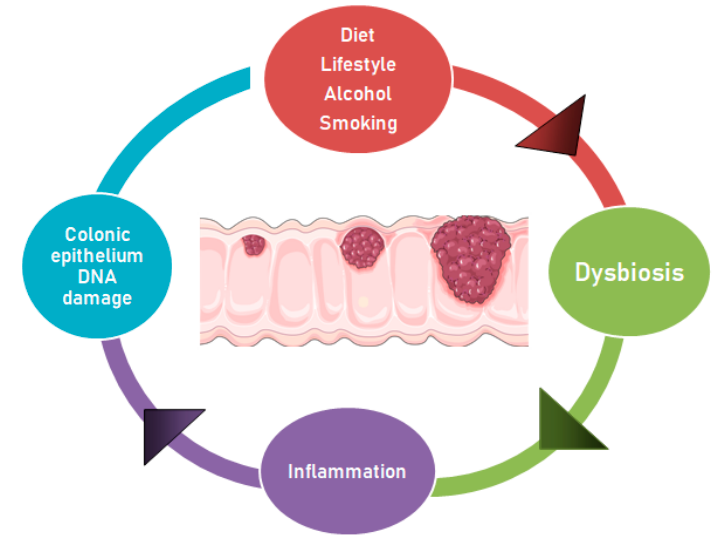
Figure 1. Dysbiosis and other factors contributing to the adenoma-carcinoma progression. The adenoma-carcinoma progression may occur because of the genomic instability caused by alterations in the gut microbiota. These changes may be supported by diet and lifestyle, which promote dysbiosis, inflammatory state and epithelial DNA damage, thus contributing to CRC development. The carcinogenesis leads to gut niche changes, which may favor the proliferation of opportunistic pathogens.